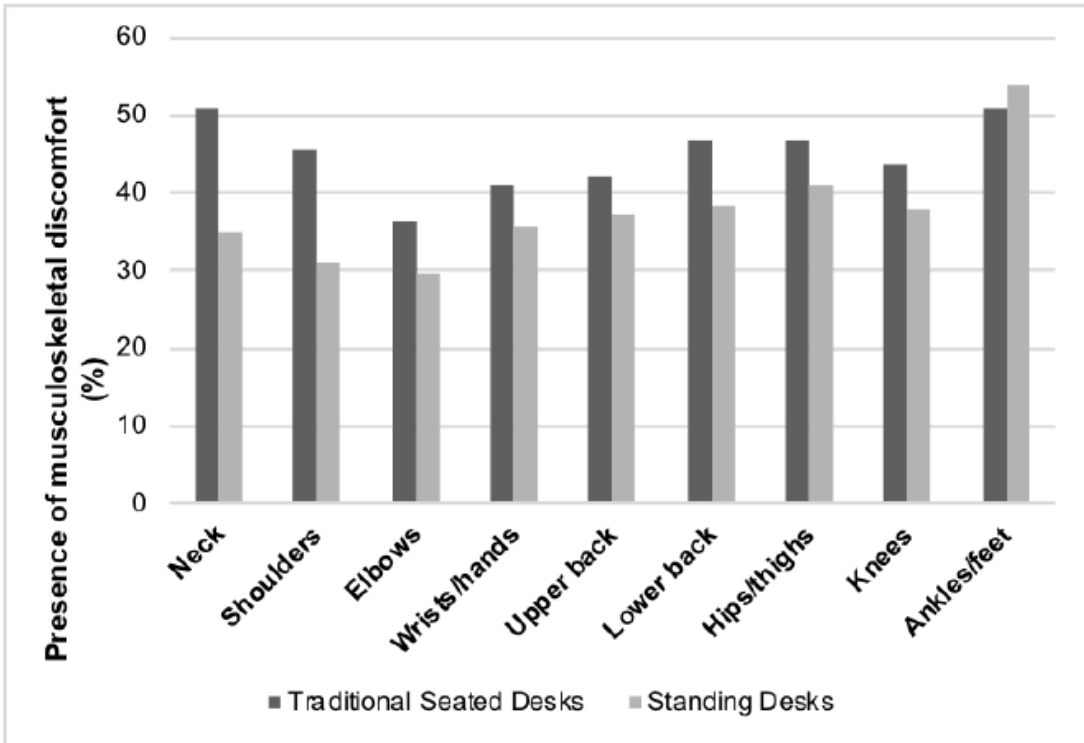
Figure 2. Percentage of participants reporting the presence of musculoskeletal discomfort at various body parts between the standing desk and seated desk conditions.